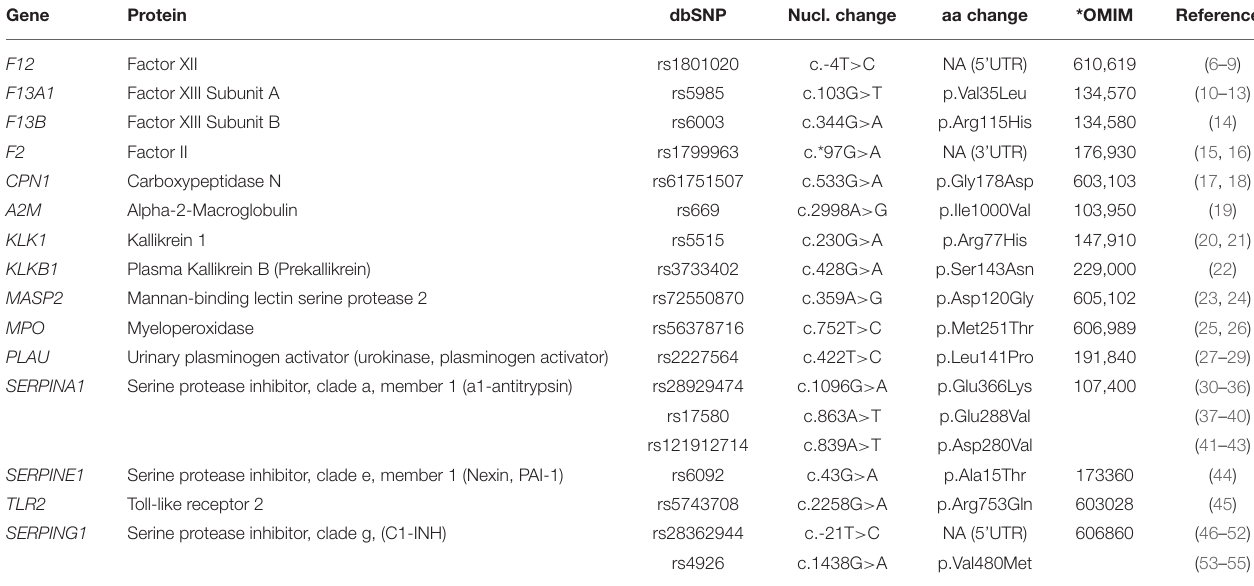
TABLE 2 | Selected common functional